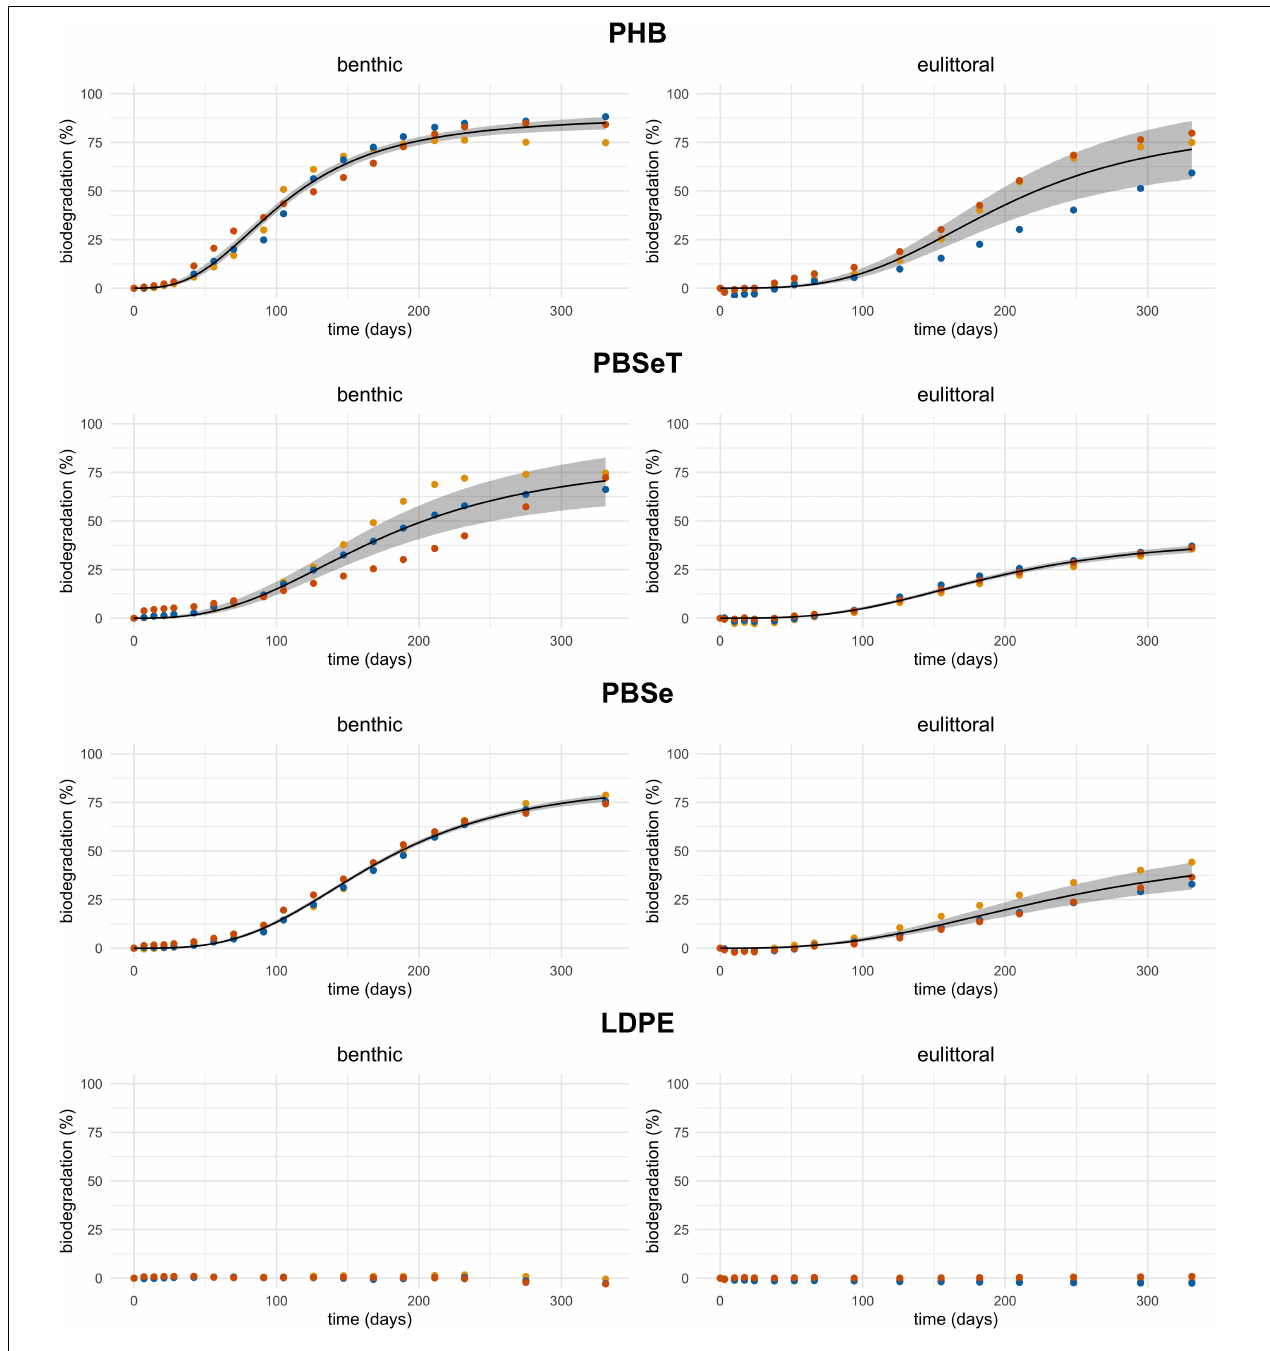
FIGURE 2 | Laboratory experiments with Mediterranean Sea water and sediment: Biodegradation curves of PHB, PBSe, and PBSeT when incubated with seafloor sediment at the sediment-seawater interface (benthic) and buried in beach sand (eulittoral). Colors red, yellow, and blue indicate samples from different test flasks, dots represent raw data analyzed in the model. The model curve ± 95% CI (shaded area) was drawn if estimated parameters were significantly different from 0.